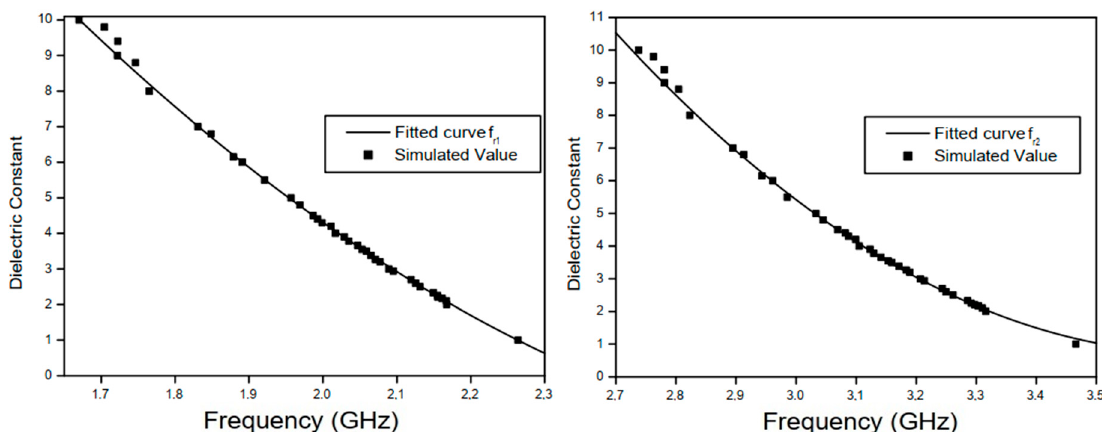
Figure 5. Fitted curves to describe the dependence of the proposed sensor resonant frequency with respect to di ff erent values of the permittivity value at ( a ) fr 1 and ( b ) fr 2 . Table 3. Fitting curves to obtain permittivity as function of resonance